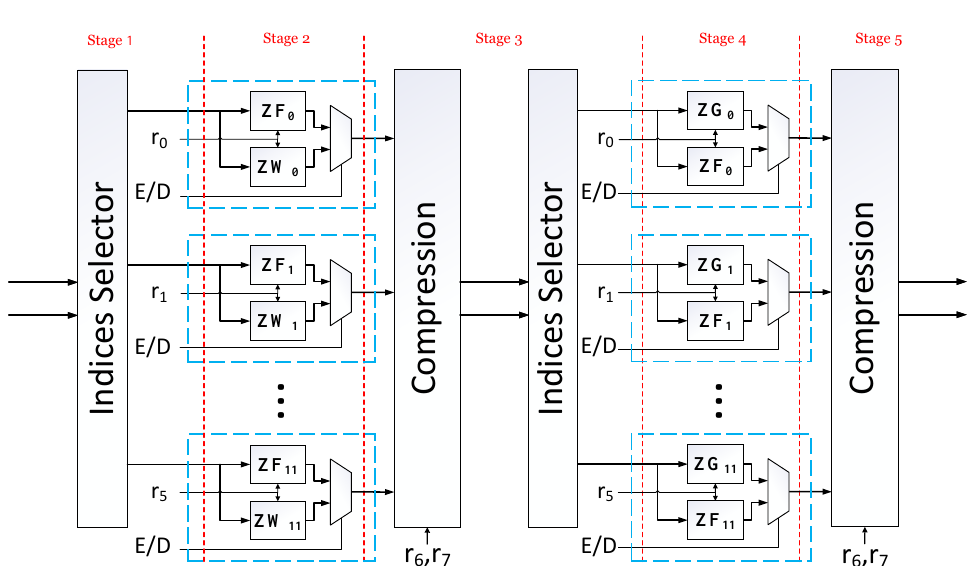
Figure 2: General structure of the combined masked AES S-box and its inverse. Red dotted lines indicate register stages, and the blue dashed lines the